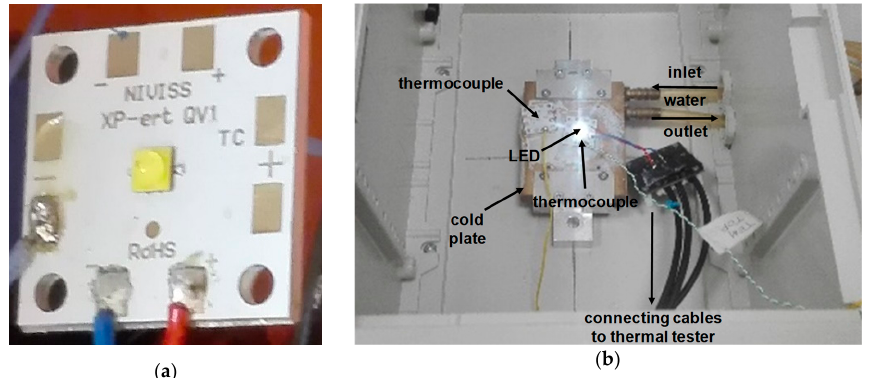
Figure 1. Photos of the experimental setup: ( a ) the investigated LED soldered to the MCPCB; ( b ) the MCPCB placed on a cold plate inside the light tight box.